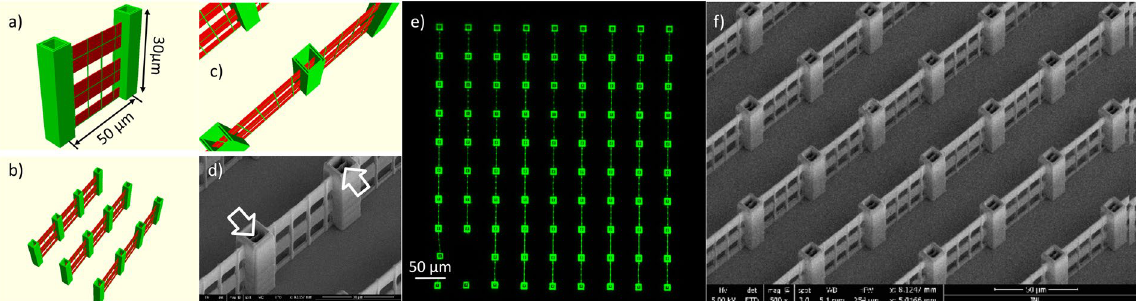
Figure 4. 3D supported test structure for multi-beam writing. ( a ) 3D visualization of the unit structure, showing traced lines in green and voxel extension in the Z-direction in red. ( b ) 3D representation of the DOE replication of 9 identical unit structures. ( c ) 3D visualization highlighting the stitching between wall segments. ( d ) Tilted-view SEM image showing the towers with internal stitching positions, highlighted by white arrows. ( e ) Confocal fluorescence image of the extended array. ( f ) Tilted-view SEM micrograph of the DOE-written structure, across a larger area of the